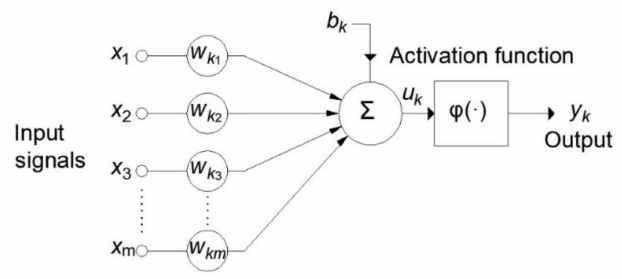
Figure 8. Nonlinear neuron model.